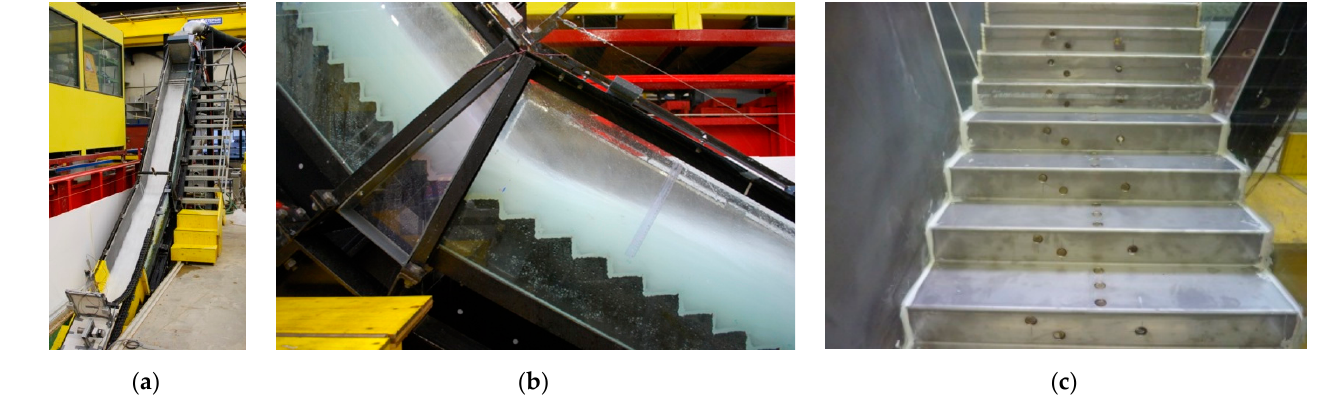
Figure 2. Physical model of the stepped spillway with an abrupt slope reduction assembled at LCH-EPFL: ( a ) General view; ( b ) Side view of configuration associated to test number 2, as per Table 1 ( θ 1 = 50 ◦ ; θ 2 = 30 ◦ ; d c / h = 4.6; F o = 6.4; R o = 4.6 × 10 5 ; W o 0.5 = 193, flow from left to the right; ( c ) Pressure transducers with 2 mm internal (cell) diameter installed in the vicinity of the 50 ◦ –30 ◦ slope